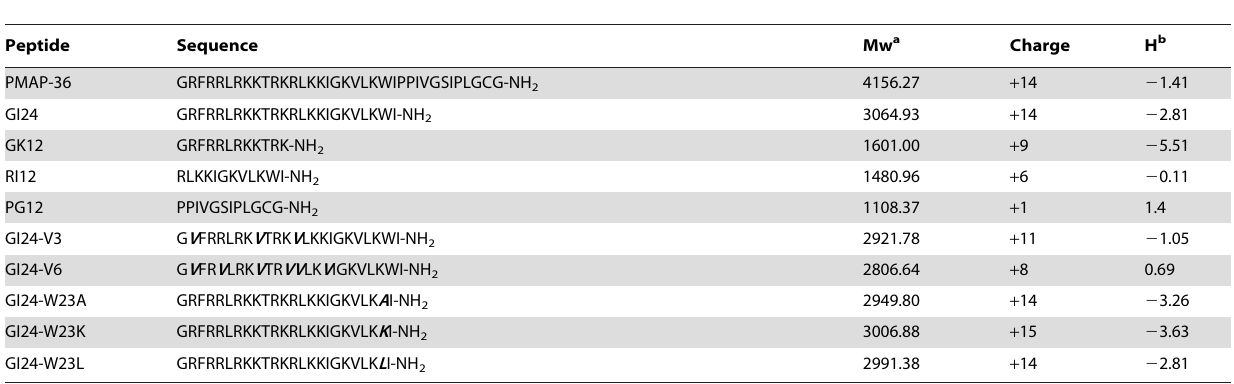
Table 1. Amino acid sequences, molecular weights, net charges, and the hydrophobicity values of the peptides.